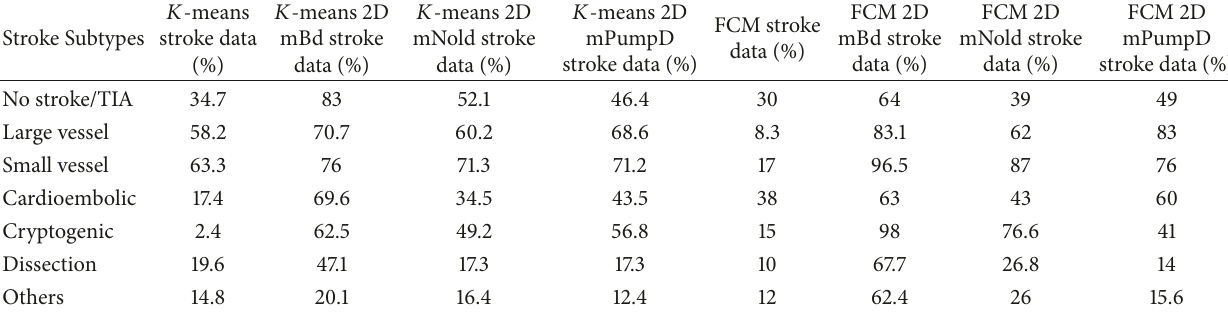
Table 8: Clustering